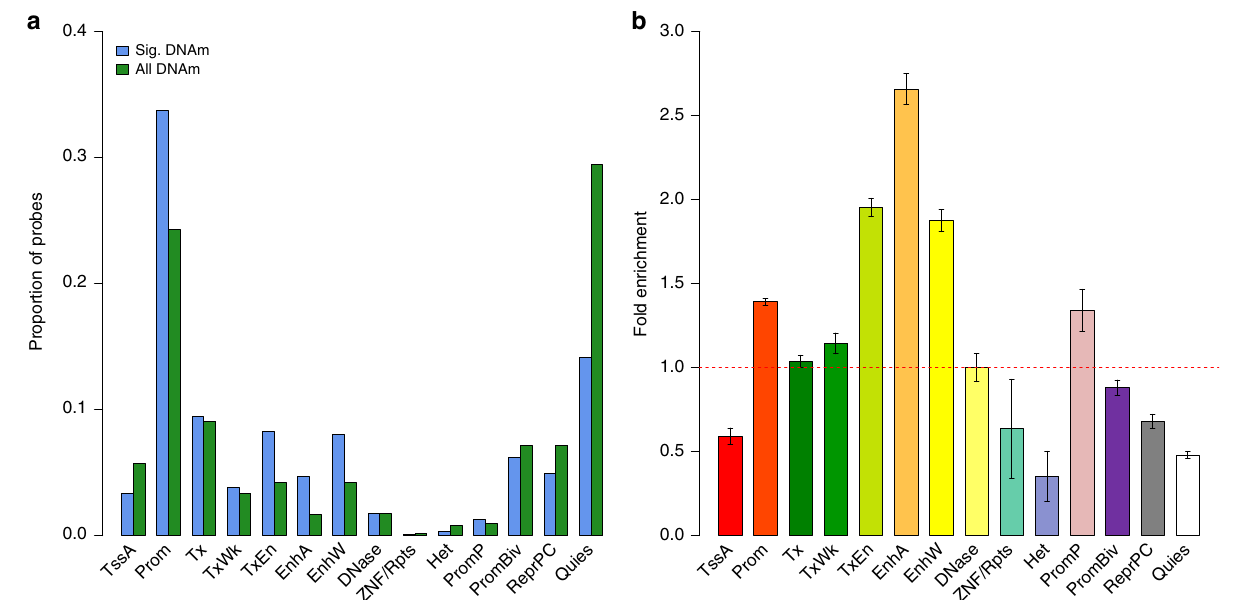
Fig. 2 Enrichment analysis of transcript-associated DNAm probes identi fi ed by the SMR & HEIDI test for 14 main functional annotation categories. a Distribution of the transcript-associated DNAm probes ('Sig. DNAm', blue) across the 14 functional categories in comparison to that of all DNAm probes in the data ('All DNAm', green). b Fold enrichment: a comparison of the associated probes with the same probes sampled repeatedly at random with the variance of each probe matched. Error bar represents the standard error of an estimate obtained from 500 random samples. The 14 functional categories are: TssA active transcription start site, Prom upstream/downstream TSS promoter, Tx actively transcribed state, TxWk weak transcription, TxEn transcribed and regulatory Prom/Enh, EnhA active enhancer, EnhW weak enhancer, DNase primary DNase, ZNF/Rpts state associated with zinc- fi